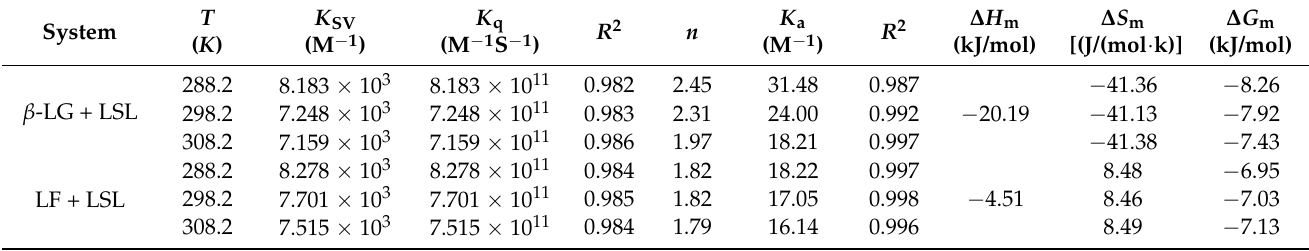
Figure 1. Fluorescence spectra of β -LG ( a ) or LF ( b ) solutions with different LSL concentrations at 298.2 K. Synchronous fluorescence spectra of β -LG (( c ), ∆ λ = 60 nm; ( d ), ∆ λ = 15 nm) or LF (( e ), ∆ λ = 60 nm; ( f ), ∆ λ = 15 nm) solutions at 298.2 K. The protein concentrations were fixed at 0.2 g/L and the LSL concentrations varied between 0~0.5 g/L. Table 1. Fluorescence quenching constants, binding constants, and thermodynamic parameters for the interactions of β -LG/LF and LSL at different